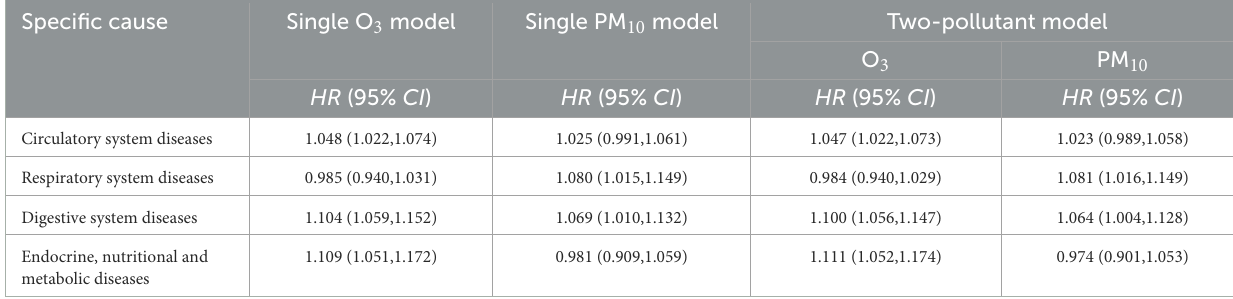
TABLE 3 Association between air pollution and cause-specific hospitalization